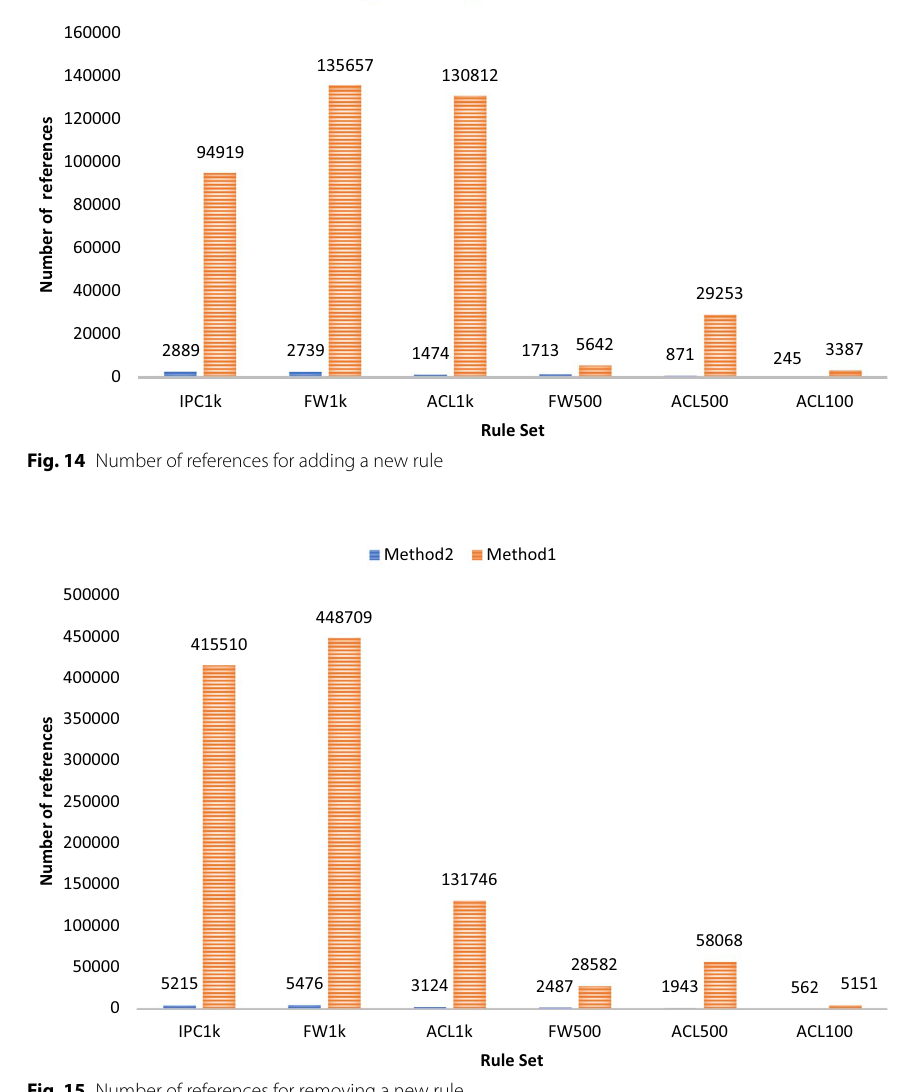
Fig. 15 Number of references for removing a new